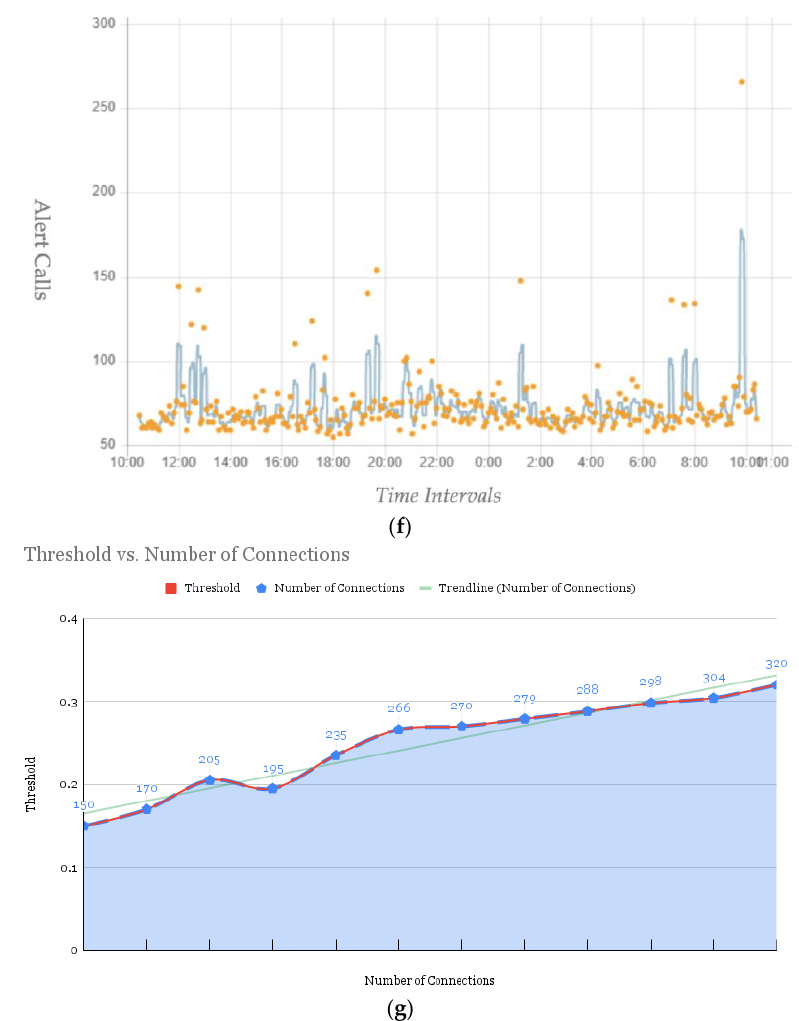
Figure 5. Network Status. ( a ) Server Connections. ( b ) Established Node Sessions. ( c ) Session Disconnections. ( d ) Sessions Deleted. ( e ) Session Reconnect Data. ( f ) Alert Generated Data. ( g ) Threshold vs. Number of Connections.